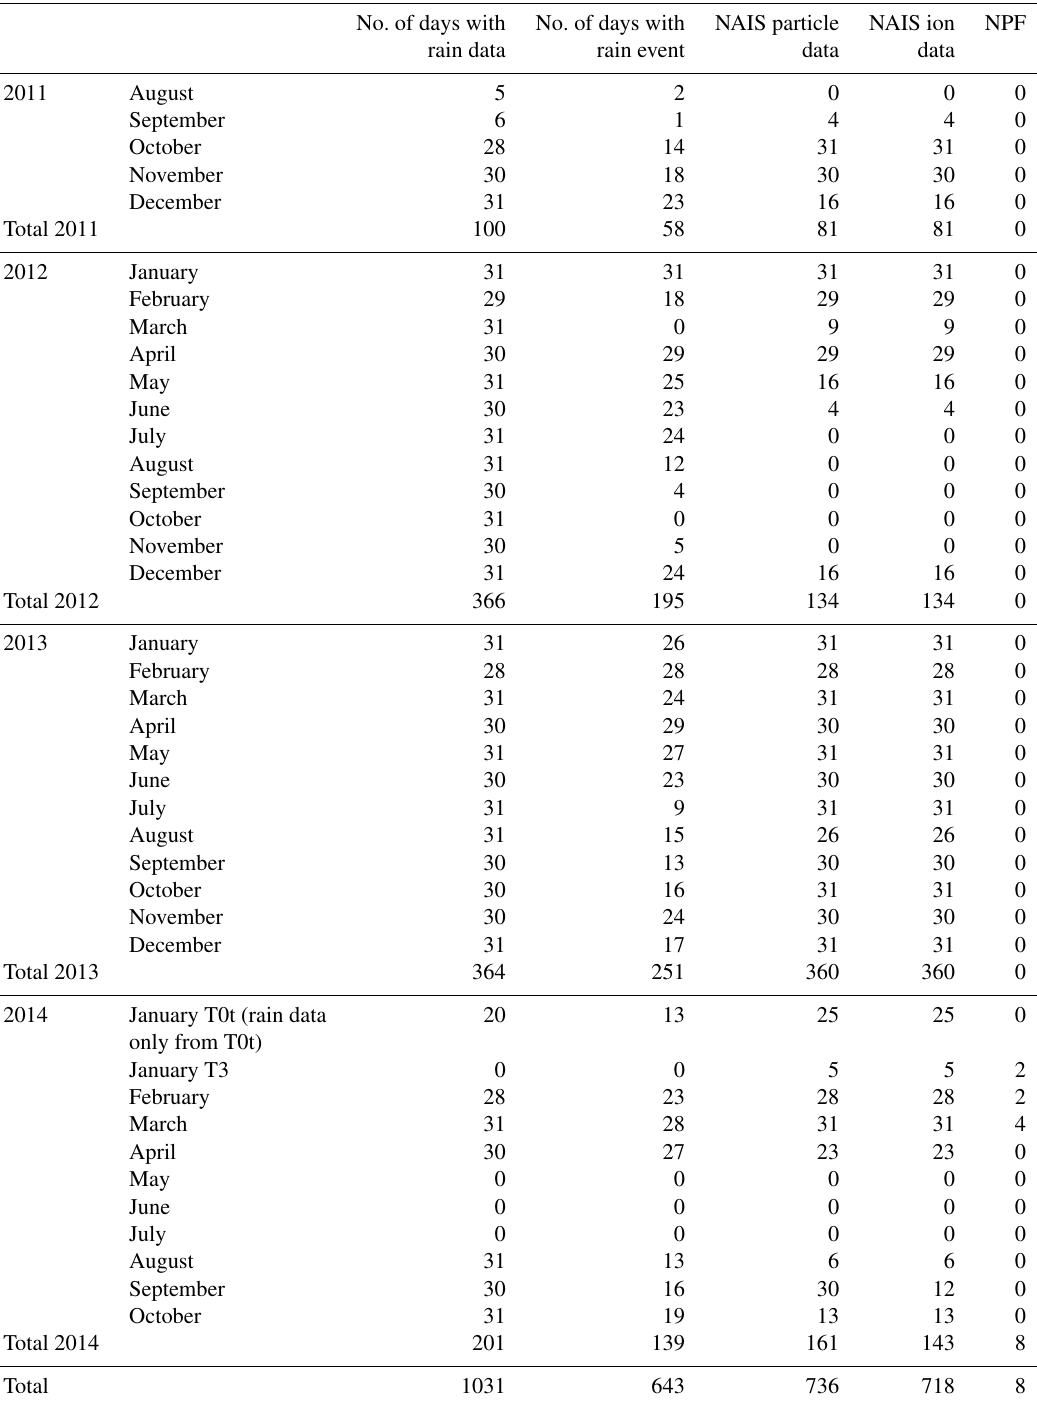
Table 1. Overall data availability for the measurements presented in the